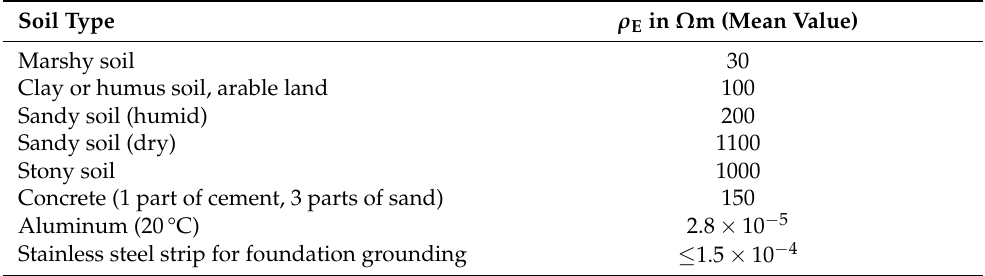
Table 4. Resistivity values for different soil types and materials, based on Reference